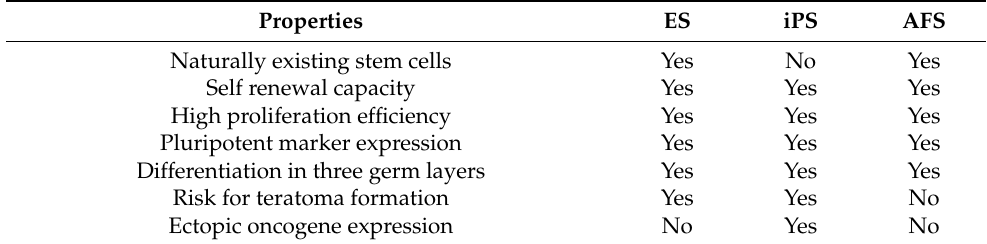
Table 1. Properties and differences between ES, iPS and AFS